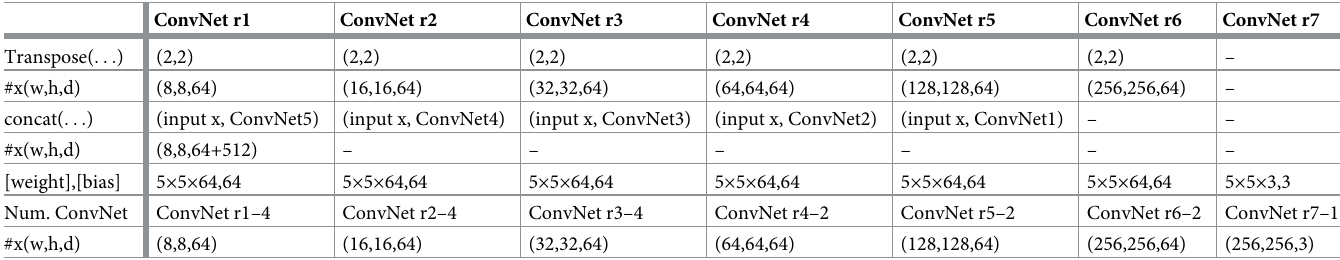
Table 2. Details of the denoising convolutional neural network architecture.